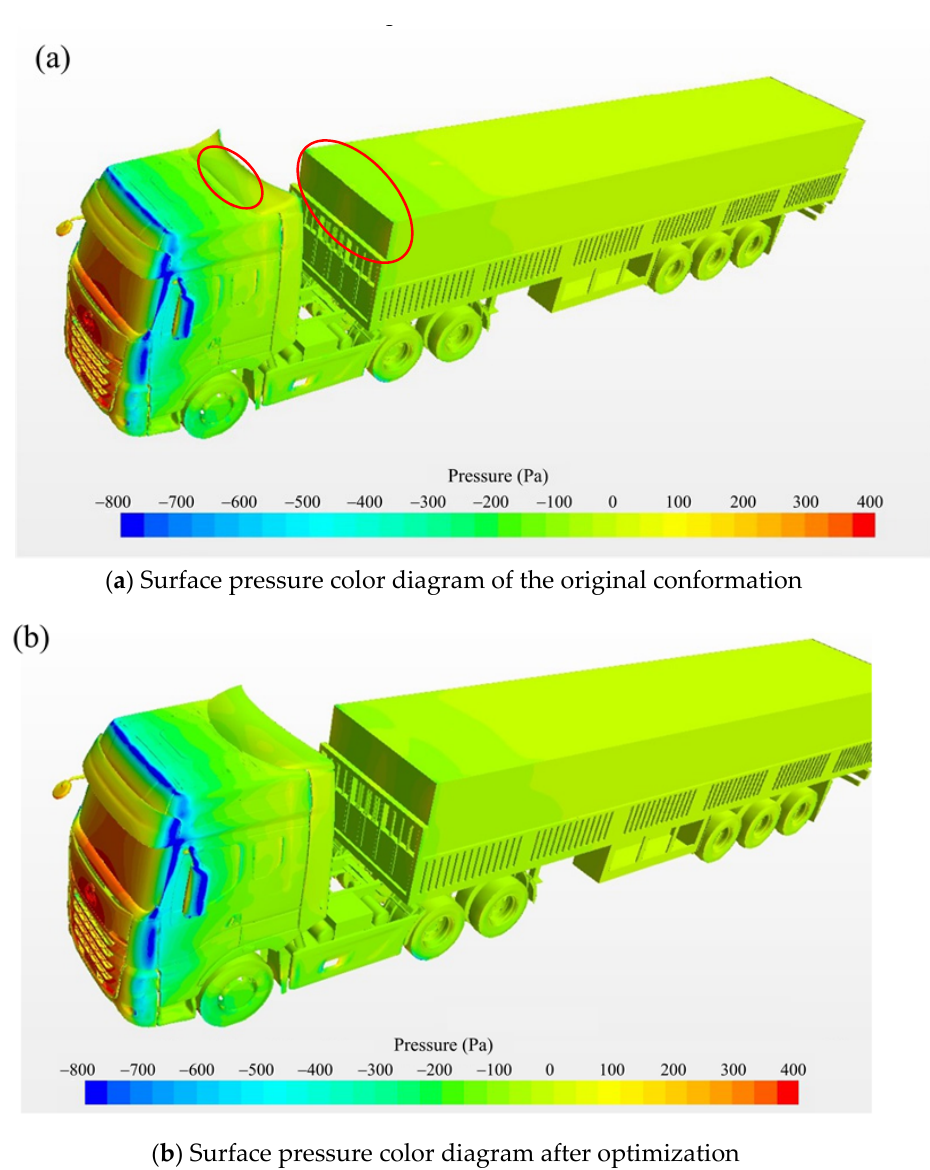
Figure 14. Surface pressure of commercial vehicles before and after optimization. Table 1. Wind resistance coefficients of the commercial